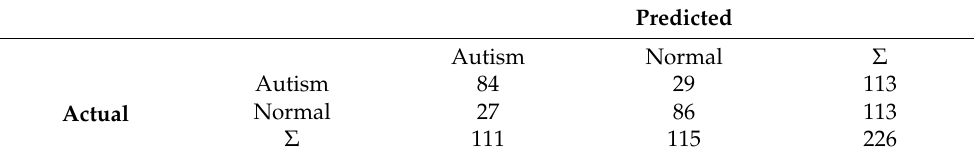
Table 10. Confusion matrix from Exp-3 (model was trained with the combined Kaggle and East Asian datasets but tested against the East Asian test dataset).